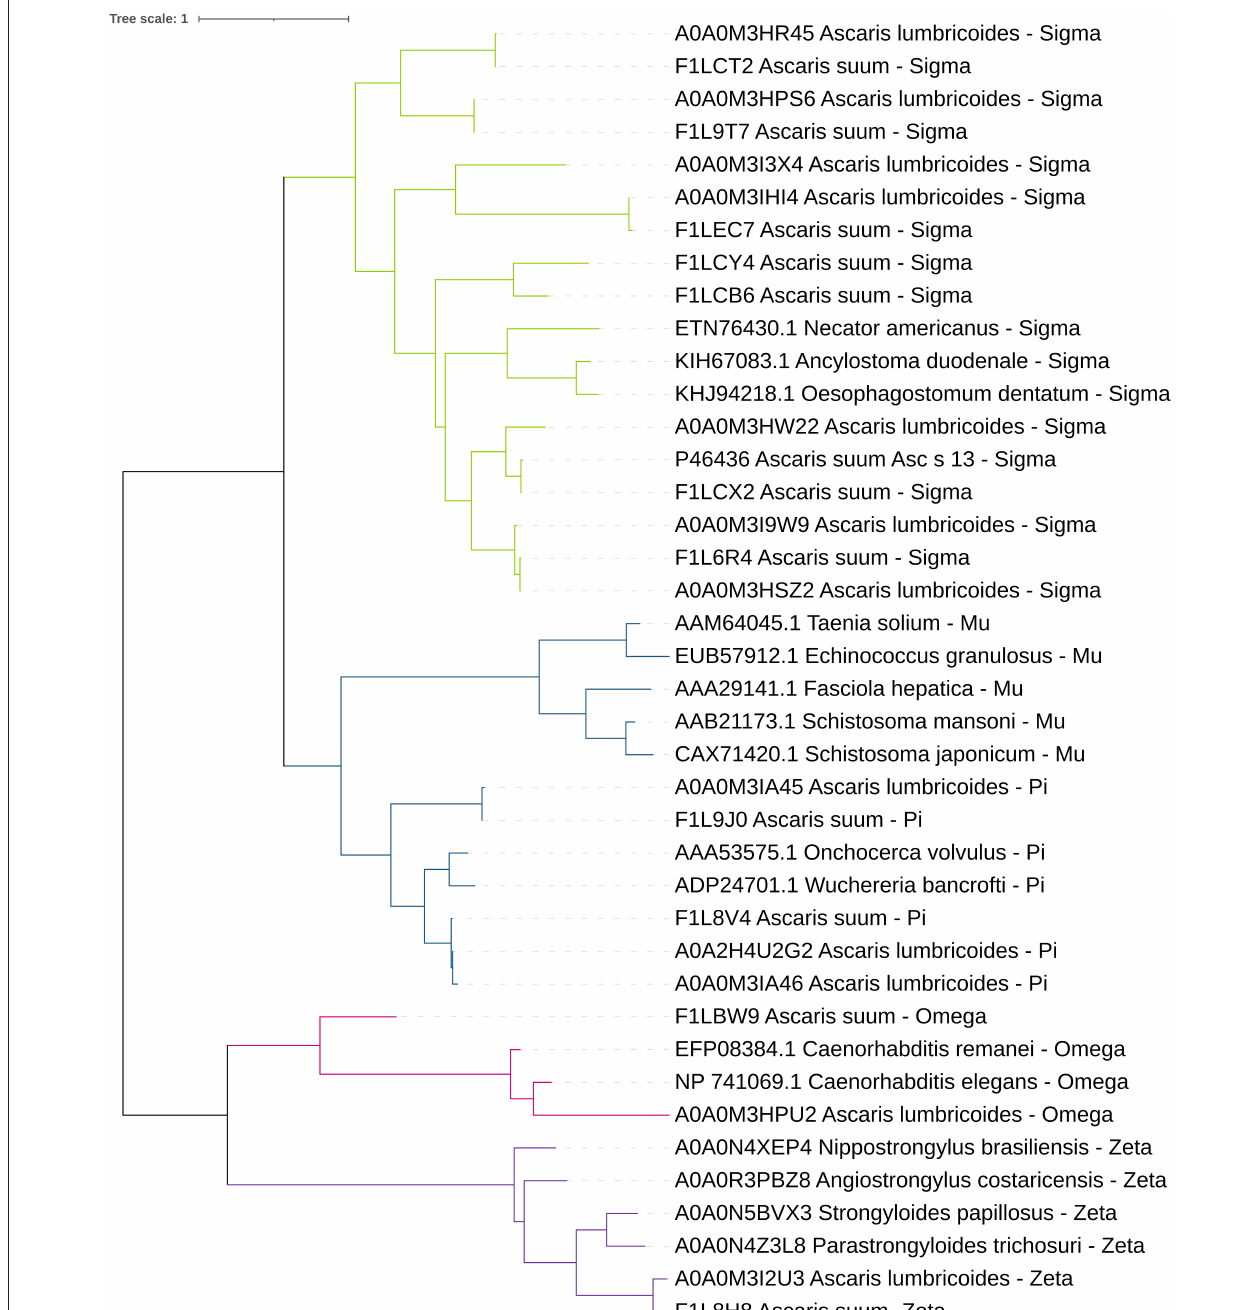
FIGURE 2 | Phylogenetic tree views of cytosolic helminth GSTs. The workflow was created in Phylogeny.fr (81). The amino acid sequences of the identified molecules were aligned using MUSCLE. The phylogenetic tree was constructed using PhyML. The editing was performed in the iTol platform (82).